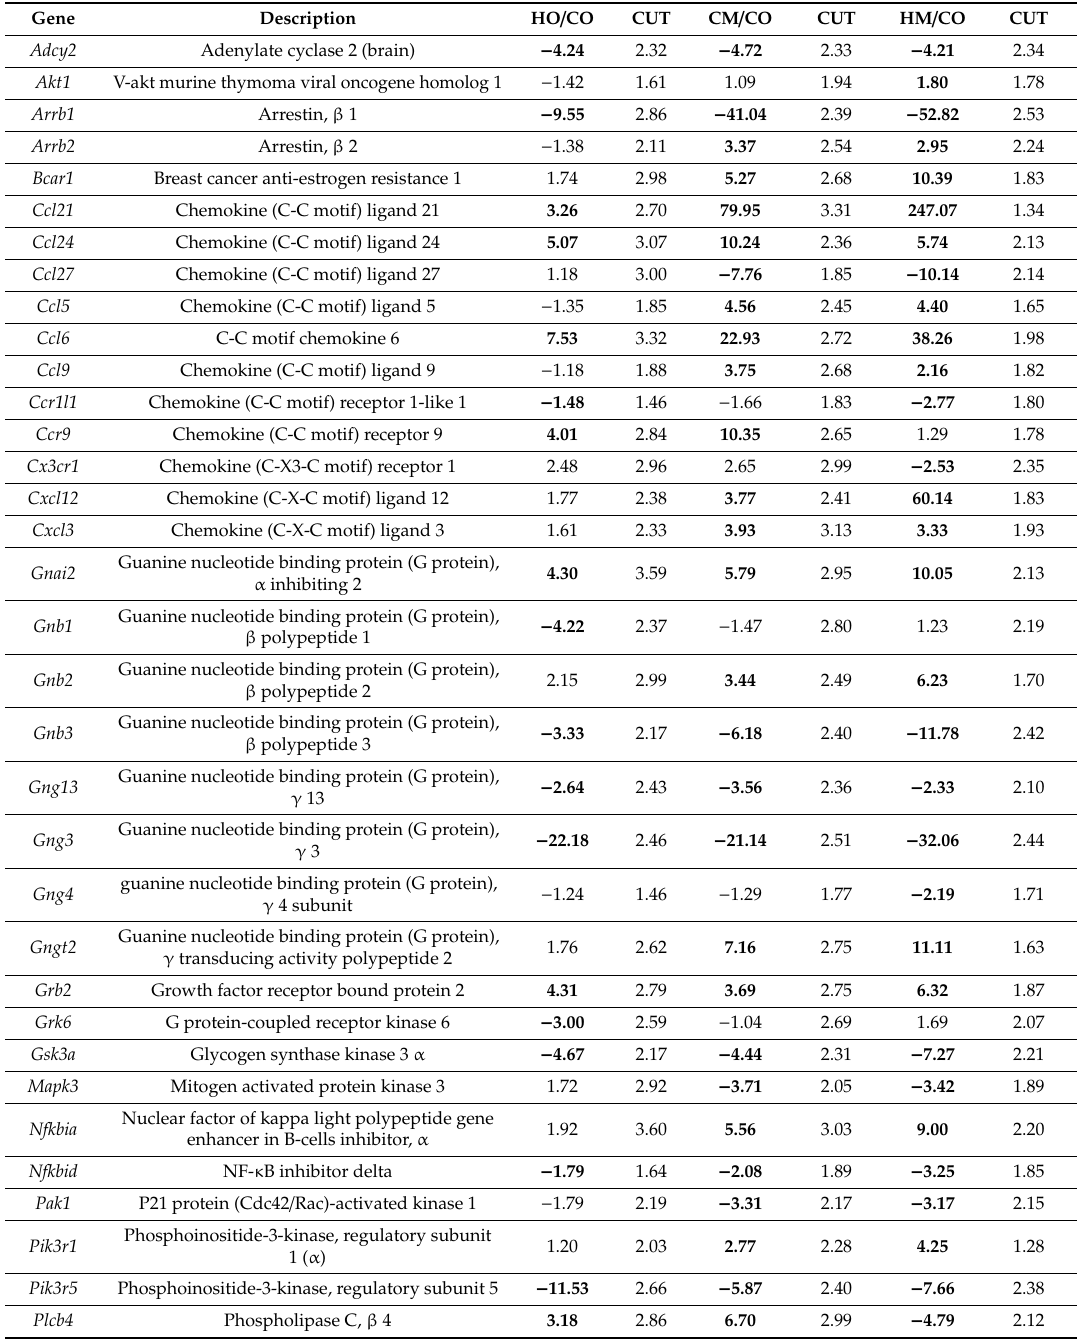
Table 1. Regulation of the chemokine signaling pathway (Kyoto Encyclopedia of Genes and Genomes (KEGG), map rno04062) genes. Significant (larger than cut-o ff (CUT)) absolute fold-changes are in bold positive numbers for upregulated and bold negative numbers for downregulated. Note the range of the CUTs, from 1.24 × (for the regulation of Rhoa in HM vs. CO) to 3.60 × (for the regulation of Nfkbia in HO vs. CO). Our procedure to determine the cut-o ff for the absolute fold-change for every gene in each comparison instead of using a fixed cut-o ff (like 1.5 × ) identified additional regulated genes (, e.g., Ccr1l1 in HO / CO). It also eliminated the false regulations (e.g., Bcar1 in HO / CO), whose absolute (although over 1.5 × ) fold-change was below the CUT (2.98) computed for that gene in the compared